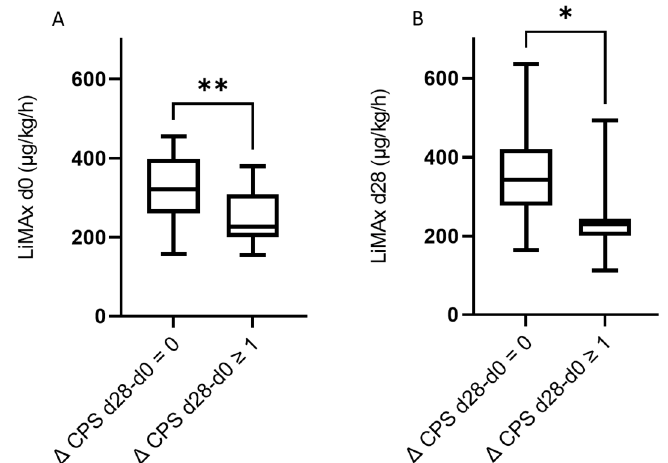
Figure 4. ( A ): Patients without any deterioration in Child–Pugh Score 28 days after RE presented significantly higher baseline LiMAx values, whole cohort ( Δ CPS d28-d0 = 0 median baseline LiMAx 321 µg/kg/h, IQR 261–398 µg/kg/h, Δ CPS d28-d0 ≥ 1 median baseline LiMAx 226.5 µg/kg/h, IQR 200.3–308.3 µg/kg/h, p = 0.004); ( B ) Patients without any deterioration in Child–Pugh Score 28 days after RE presented significantly higher LiMAx values 28 days after RE, only prospective cohort ( Δ CPS d28-d0 = 0 median baseline LiMAx 342 µg/kg/h, IQR 277–420.5 µg/kg/h, Δ CPS d28-d0 ≥ 1 median baseline LiMAx 229 µg/kg/h, IQR 199.5–243.5 µg/kg/h, p = 0.02). * = p < 0.05, ** = p < 0.01.